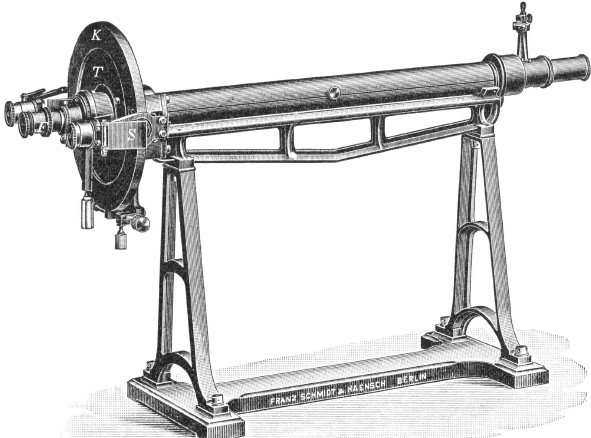
Figure 4. A polarimeter for research on optically active organic liquids and solutions. A liquid sample which is contained in a long enclosed glass tube between two Nicol prisms, rotates the plane of polarization of light passing through. From Struers’ (1925)